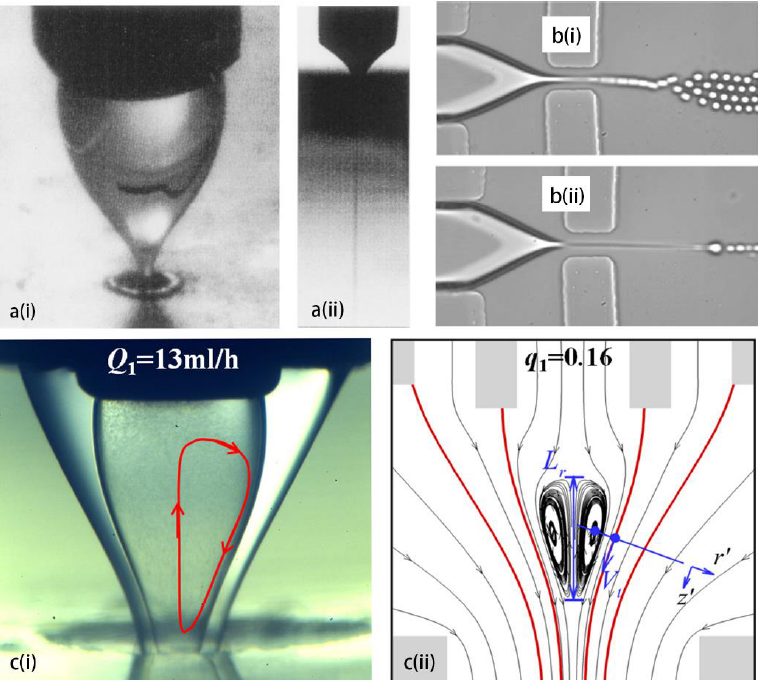
Figure 1. Methods of hydrodynamic tipstreaming. ( a ) 3D flow focusing of disperse fluid by gas stream through an orifice ( i ), and the formed thin jet which eventually breaks into tiny droplets ( ii ), reproduced from [29], copyright 1998, American Physical Society. ( b ) Tipstreaming in a planar PDMS channel from dripping mode ( i ) and jetting mode ( ii ), reproduced from [34], copyright 2003, AIP. ( c ) Conical interface of compound thread in co-axial flow focusing, recirculation zone in the cone is illustrated by PIV ( i ), and by numerical calculation ( ii ), reproduced from [36], copyright 2022, American Physical Society.